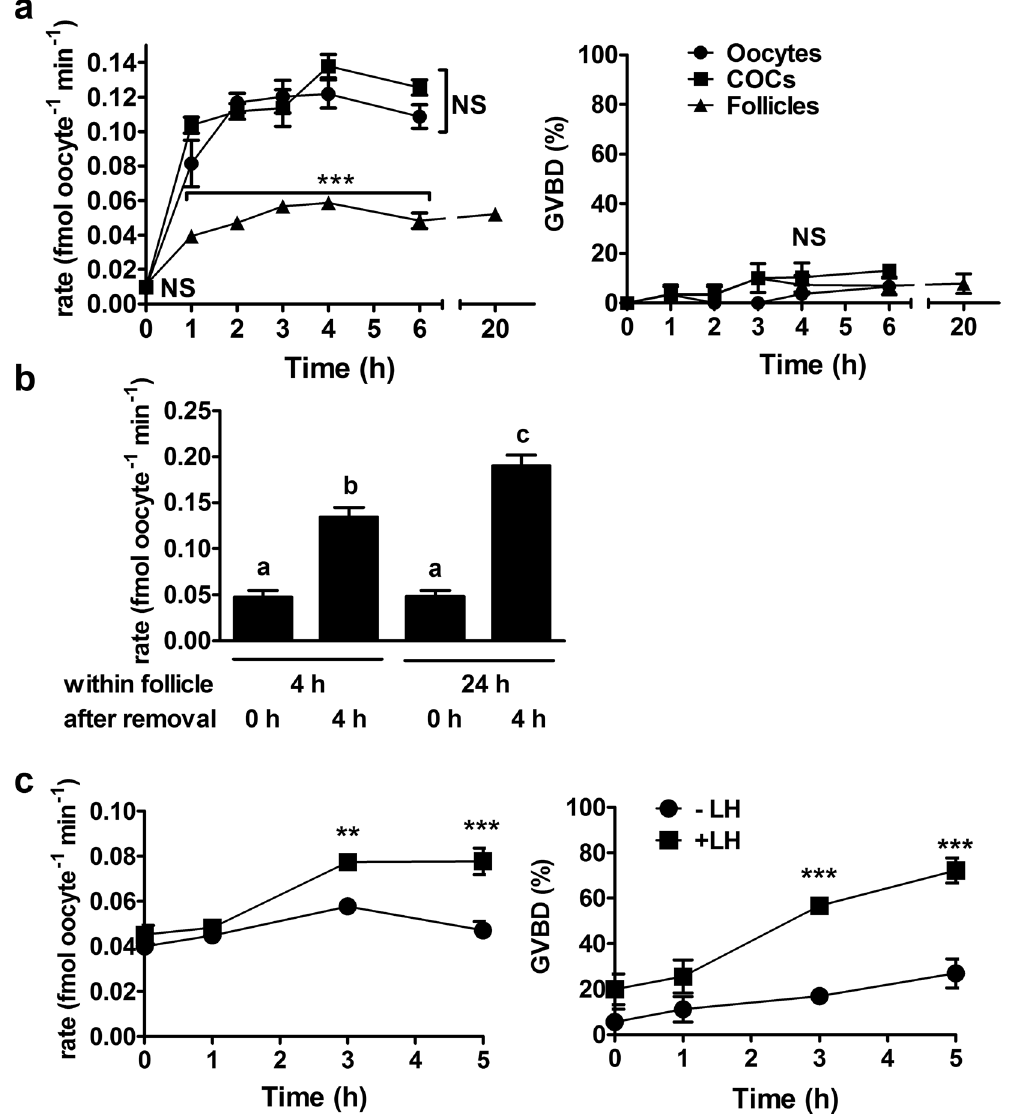
Figure 1. GLYT1 activity in oocytes, COCs and intact follicles. ( a ) GLYT1 activity (rate of [ 3 H]-glycine transport) was measured as a function of time after isolation of GV oocytes, COCs, or intact antral follicles. For oocytes and COCs, meiotic arrest was maintained with dbcAMP or NPPC/E 2 , respectively. Points represent the mean ± s.e.m. of GLYT1 activity (left) or GVBD (right) for three independent repeats at each time. Data were analysed by 2-way ANOVA with Bonferroni post-test, which indicated significant difference between follicles vs. COCs and GV oocytes at each time from 1–6 h (overall effect between preparations, P < 0.0001; between preparations at each time point: *** P < 0.001), but not between COCs and oocytes (NS, P > 0.05). At 20 h, activity was measured only for oocytes from cultured antral follicles (not included in analysis). There was no significant difference between preparations for GVBD (NS; P = 0.096 by 2-way ANOVA). ( b ) To assess reversibility of GLYT1 suppression in vitro , antral follicles were cultured for 4 or 24 h as indicated and then the oocytes removed and GLYT1 activity measured immediately (0 h) or after a further 4 h of culture of isolated oocytes. GLYT1 remained suppressed in oocytes within antral follicles for 4 or 24 h, but became activated 4 h after removal. Each bar represents the mean ± s.e.m. of five independent repeats. The effect was significant (overall P < 0.0001 by ANOVA). Bars that do not share the same letter are significantly different (Tukey test; P < 0.001 except b vs c, P < 0.01). ( c ) Antral follicles were isolated from P21 neonates and cultured overnight with FSH to stimulate LH receptor expression, and then cultured for up to 5 h in the continued absence ( − LH) or presence ( + LH) of LH, after which the oocytes were isolated and GLYT1 activity measured (left) and GV status determined (right). Each point represents the mean ± s.e.m. of three independent repeats at each time. There was a significant difference between the presence vs. absence of LH at 3 and 5 h for both GLYT1 activity and GVBD (2-way ANOVA with Bonferroni post-test; overall effect of LH: P < 0.0001; between individual time points: a ** P < 0.01; *** P <